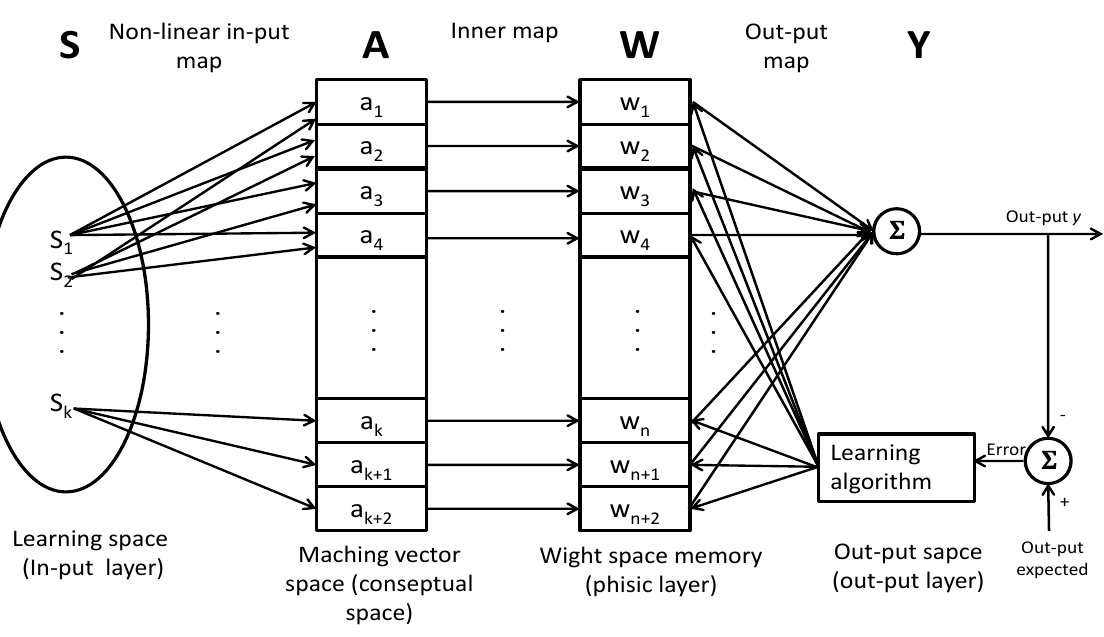
Figure 3. Artificial neural network (ANN) CMAC